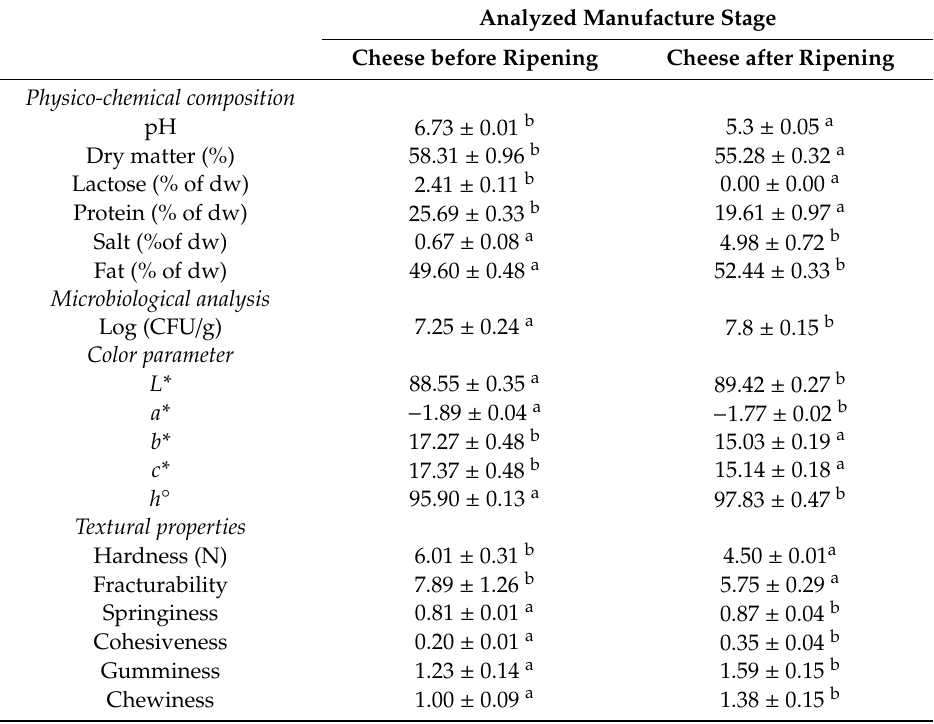
Table 2. Comparison of selected physico-chemical composition, microbial population and texture parameters of cheeses analyzed at di ff erent stages of the ripening process. Analyzed Manufacture Stage Cheese before Ripening Cheese after